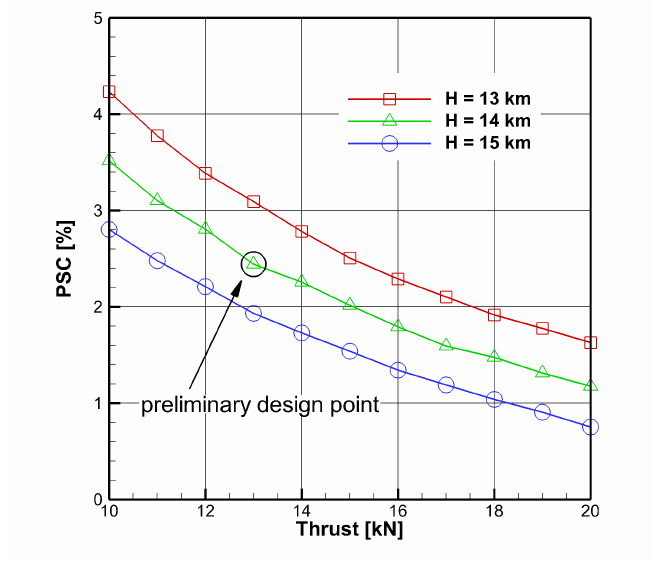
Figure 10. Power saving coefficient for varying altitudes, r Fan =